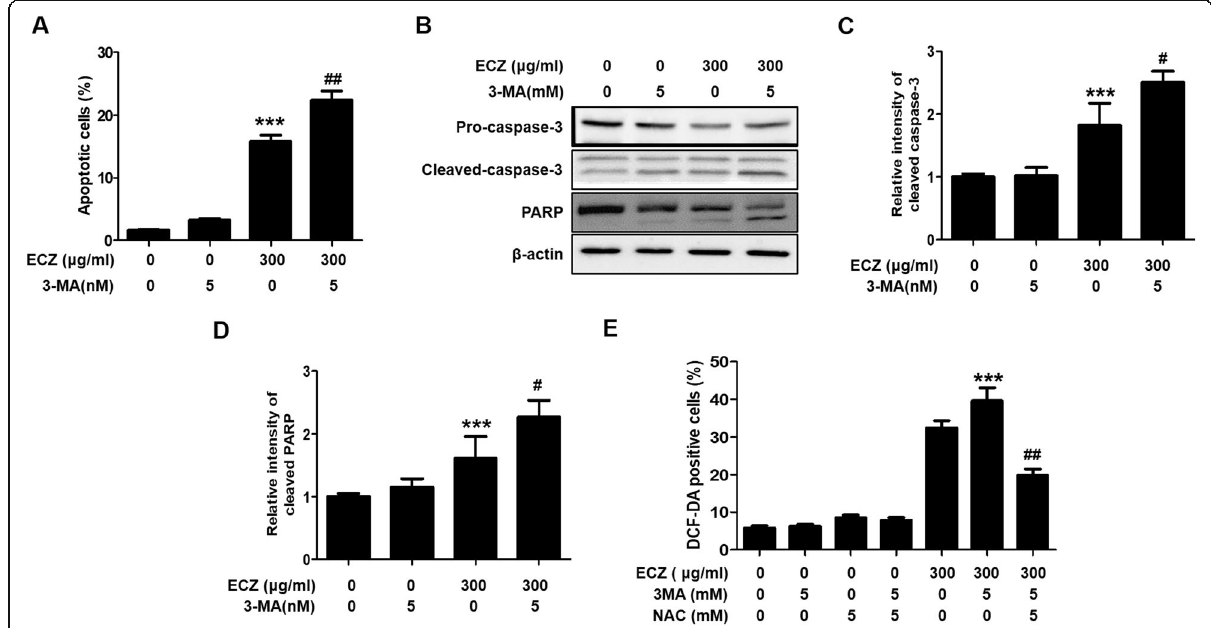
Fig. 5 Inhibition of autophagy enhanced apoptosis induced by ethanol extracts of Chrysanthemum zawadskii Herbich (ECZ) by increasing the production of reactive oxygen species (ROS) in mouse colon cancer CT-26 cells. a Treatment with 3-methyladenine (3-MA) enhanced ECZ- induced apoptosis. b Effects of 3-MA treatment on caspase-3 and poly (ADP-ribose) polymerase (PARP) expression. c Relative fold change of cleaved caspase-3. d Relative fold change of PARP. Cells were pretreated with 5 mM 3-MA prior to 1 h. Apoptotic cells were evaluated by flow cytometry, and the proteins were detected by Western blot analysis. e Effects of 3-MA on ROS production. Cells were treated with 300 μ g/ml ECZ for 24 h prior to 1 h incubation with 5 mM 3-MA or/and 5 mM NAC. ROS production was evaluated by flow cytometry. Data are presented as the mean ± standard deviation for at least three independent experiments. ***p < 0.001 vs. the control group, #p < 0.05, ## p < 0.01 vs. the ECZ treated